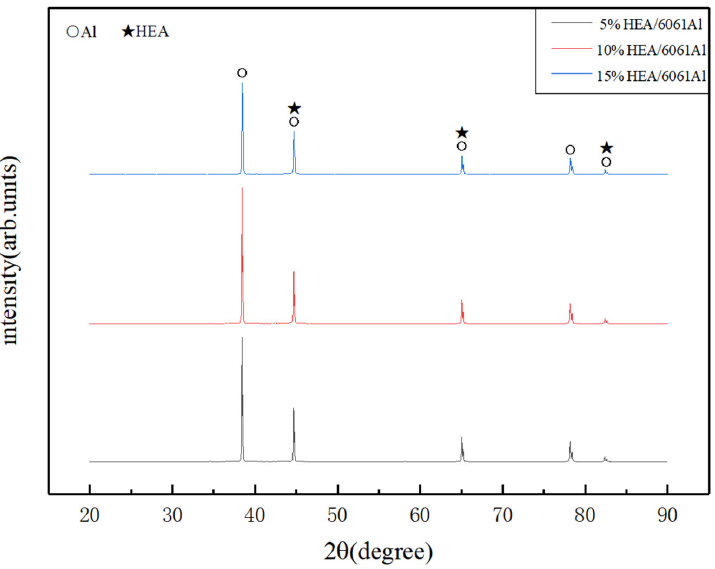
Figure 4. XRD patterns of 5 vol.%, 10 vol.%, and 15 vol.% AlFeNiCrCoTi0.5p/6061Al powders.